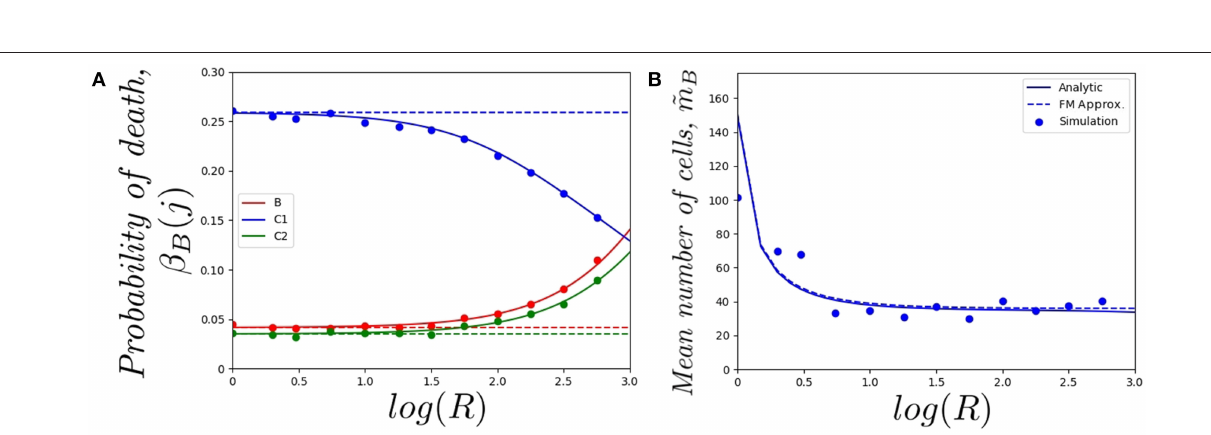
FIGURE 4 | Effect of changing the value of R on (A) the mean total number of division events ˆ m B , and (B) the mean number of division events occurring in compartment j , ˆ m B ( j ), for j ∈ { B , C 1 , C 2 } . We consider a single cell starting in the blood. Analytic solution ( solid ), fast-migration approximation ( dashed ) and 10 4 stochastic simulations ( dots ).